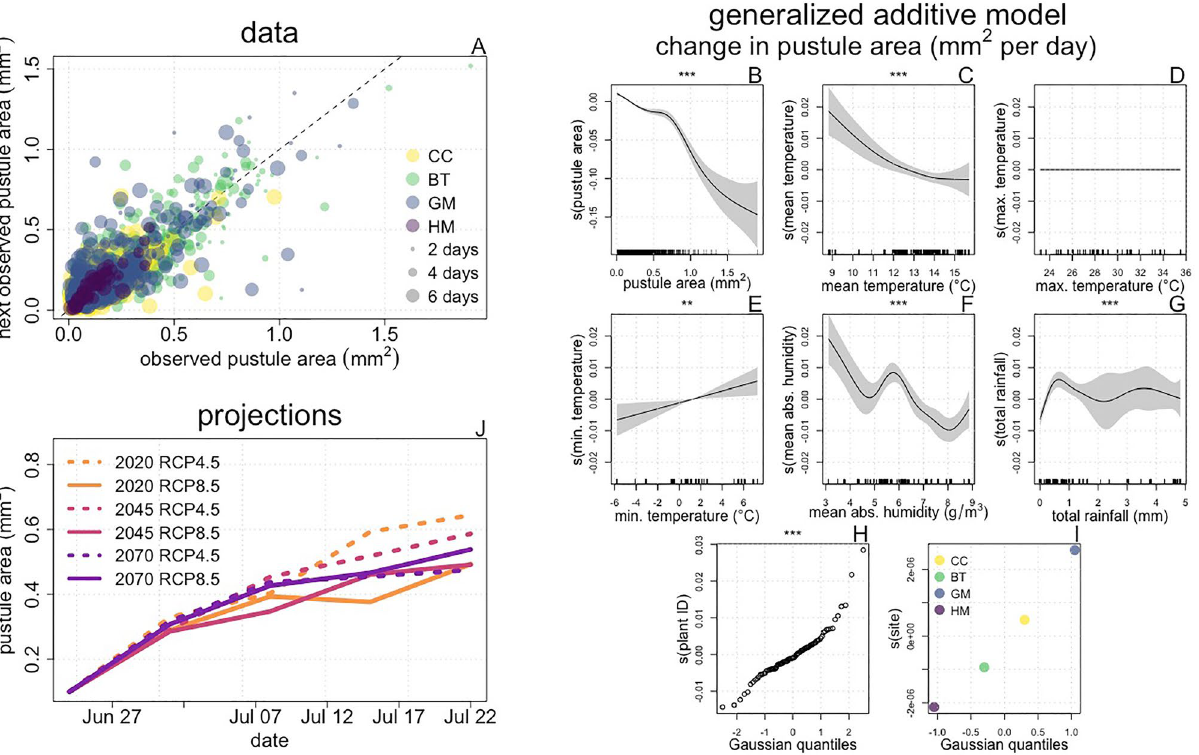
Figure 2. The effects of climate change on M. lini replication rate. Data: We made 3319 observations of pustule area from 1434 individual pustules located on 84 diseased focal plants. Panel ( A ) shows this data, with each point representing one observation. Color indicates study site, and size represents the elapsed time between observations. While changes in pustule area capture pustule growth, they also capture processes that decrease pustule size (e.g. wind and rain damage, which may potentially contribute to spore dispersal), so both positive and negative changes are expected. The dashed line shows y = x to illustrate where increases (points above the line) and decreases (points below the line) in pustule area occur. Generalized additive model: We fit a GAM with an identity link function to this data, using change in pustule area per day as the response variable and smooth terms for weather variables and pustule area as predictors. We also included source plant identity and study site as random effect smooths to account for the nested nature of our data. Panels ( B – I ) show the value of the fitted smooths (i.e. ‘s(x)’) for different values of the predictor variables. Symbols above plots show the significance of smooth terms, with *** indicating p < 0.001, ** indicating p < 0.01, and * indicating p < 0.05. In the model fitting and selection procedure, smooth terms lacking explanatory power are set to have no effect and thus are functionally removed from the model, as seen in panel ( D ). In panels ( B – E ), lines show the fitted value of the smooth, and shading represents ± 2 standard errors. Ticks along the horizontal axis represent observed weather metrics. In Panels ( H ) and ( I ), points show the fitted values of random effects vs. the quantile of their fitted value. Projections: Using the fitted GAM model, we 100 simulated trajectories of pustule growth for a small pustule (starting with area 0.1 mm 2 ) at the four study sites for each of six future weather data sets. Panel ( J ) shows the means of trajectories simulated for the GM site. These qualitatively match results for other sites (Supplementary Fig.